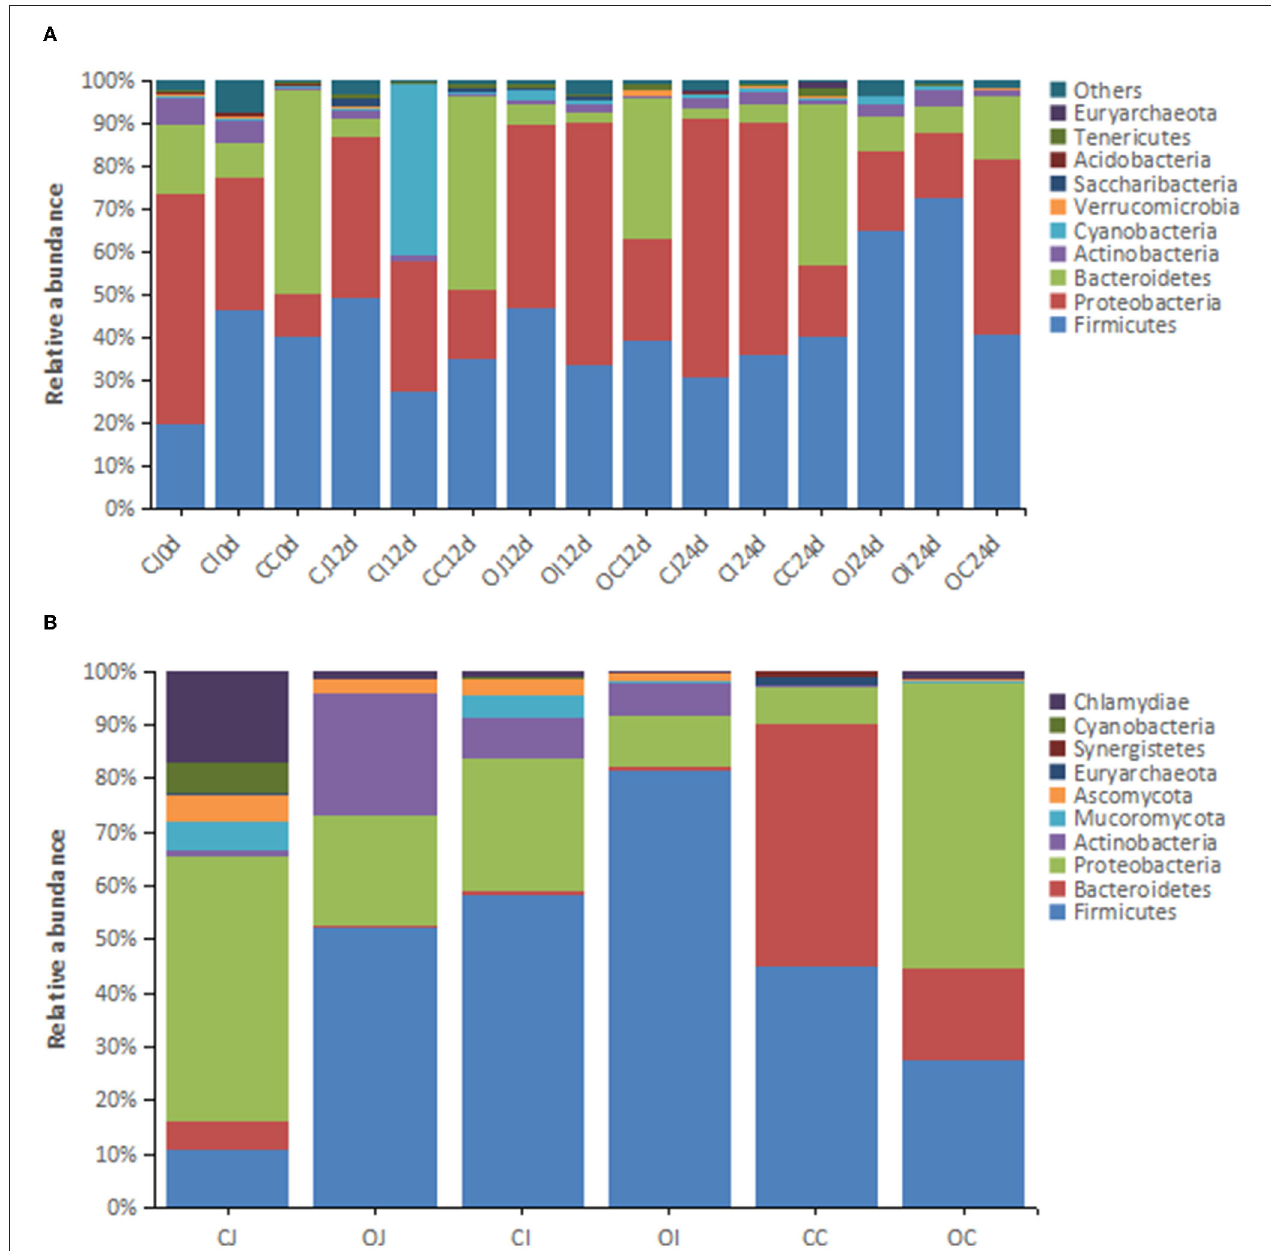
FIGURE 1 | The histograms showing the relative abundance of the top 10 phyla in different intestinal tracts revealed by (A) 16S rRNA analysis ( n = 16) and (B) metagenomic analysis ( n = 4). Note: “CJ” and “OJ” denote the jejunal tracts of the control group and the overfeeding group, respectively. “CI” and “OI” denote the ileal tracts of the control group and the overfeeding group, respectively. “CC” and “OC” denote the cecal tracts of the control group and the overfeeding group,